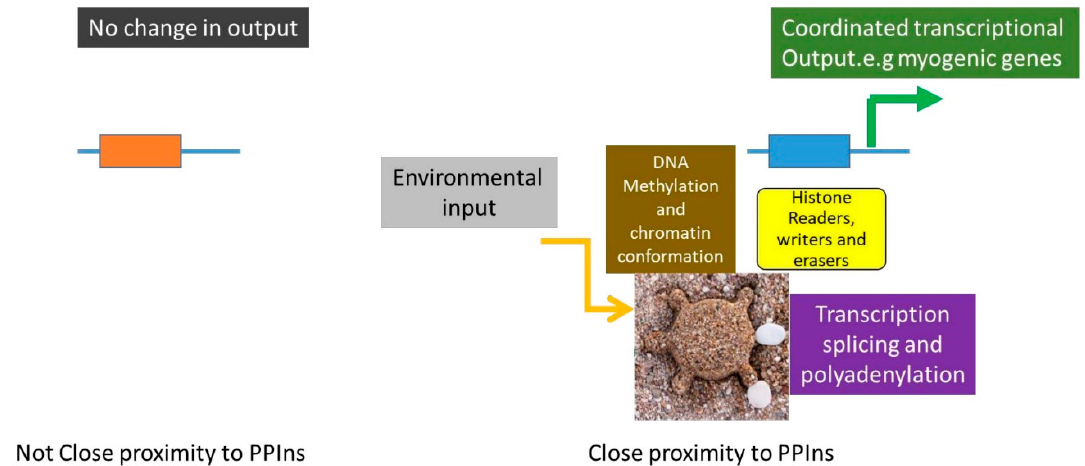
Figure 6. Depicts how changes in localised platforms of nuclear PPIns, such as at nuclear speckles, might impact on transcriptional output of genes that are in close proximity to the nuclear speckle through the recruitment of a group of proteins that modify DNA methylation, histone modification and regulate mRNA transcription, splicing and maturation. On the other hand genes that are not close to PPIns containing speckles would not be regulated by changes in nuclear PPIns. This would potentially explain selective gene regulation by PPIns binding proteins.